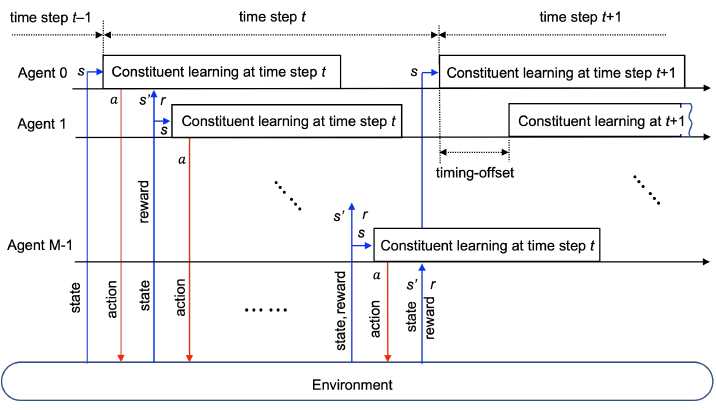
Figure 4. Learning of multiple agents in a cyclic